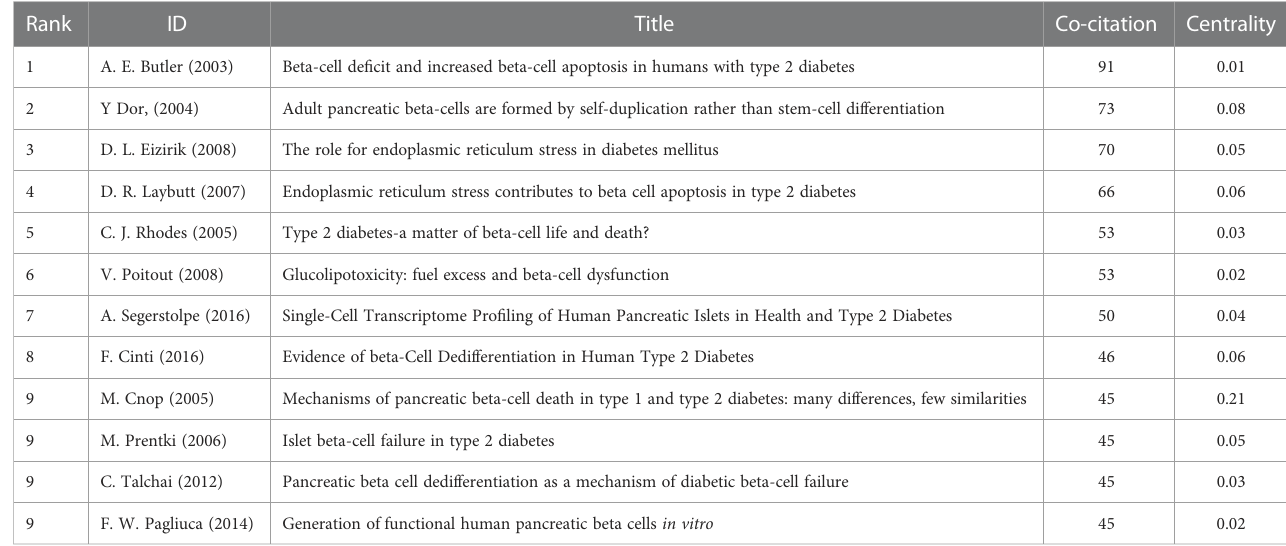
TABLE 5 Top 12 co-cited references related to beta-cell